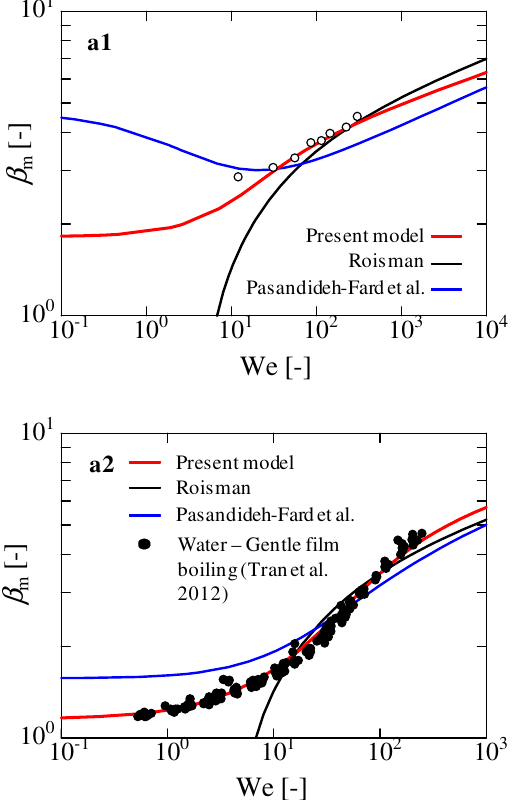
Figure 5. Comparison of our theory with existing experimental data. (a1) Plots of β m versus We. The white circle represents ethanol on Al. The solid red, blue, and black lines represent analytical results from our theory, Pasandideh-Fard et al . 10 , and Roisman 27 , respectively. The droplet volume V 0 is 8.2 μ L. The values of θ for ethanol used is 26.8° for our model. θ d for Pasandideh-Fard et al . is 35.2°. (a2) Plots of β m versus We for a water droplet on a heated substrate. The black circles represent the existing experimental data for water undergoing gentle film boiling on a heated silicon wafer 19 . The solid red, blue, and black lines represent the results of our model, and those of Pasandideh-Fard et al . 10 and Roisman 27 , respectively. In our model, droplet volume is set to 6 μ L. The same value of θ as the water on SR case ( θ = 122.6°) is used in our experiment for each analytical result since the value of the dynamic contact angle was not reported. θ d for Pasandideh-Fard et al . is also the same value of θ d as the water on SR case ( θ d =